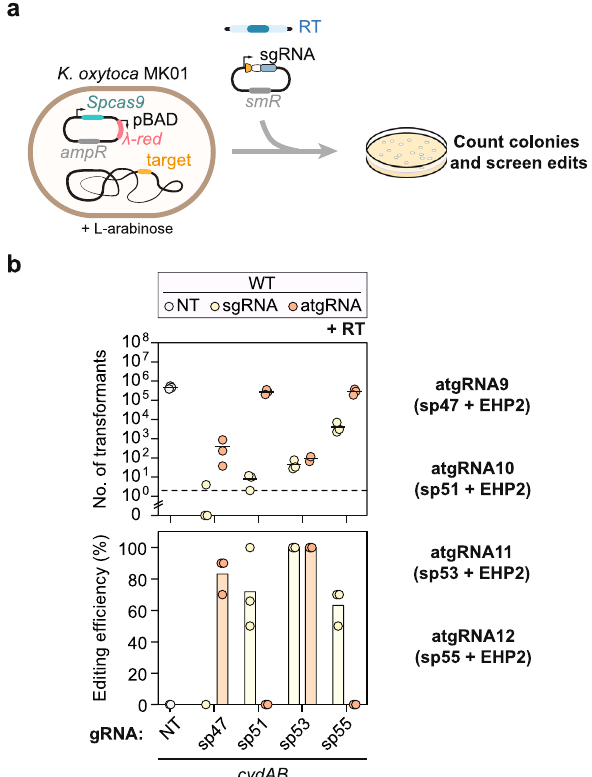
Fig.4|AnattenuatedgRNAenhanceseditingin Klebsiellaoxytoca .a Schematic ofgenomeeditingexperimentalsetup. b Genometargetingassayin K.oxytoca with sgRNAs and atgRNAs to delete cydAB . Individual dots for the transformations indicate a single biological replicate. Dashed lines indicate the limit of detection fromplating.NTindicatesnon-targeting.Individualdotsfortheeditingef fi ciencies indicate the average of 3 colonies screened from one biological replicate for NT samples or 10 colonies screened from one biological replicate for targeting sam- ples. Bars indicate the mean of the dots. The dashed line indicates the limit-of- detection.SeeFig.1fordetails. The mean numberof transformants(indicatedbya horizontal line) was not calculated for samples with biological replicates that fell belowthe limit of detection. WT indicates wild-type K.oxytoca MK01, NT indicates non-targeting, and RT indicates repair